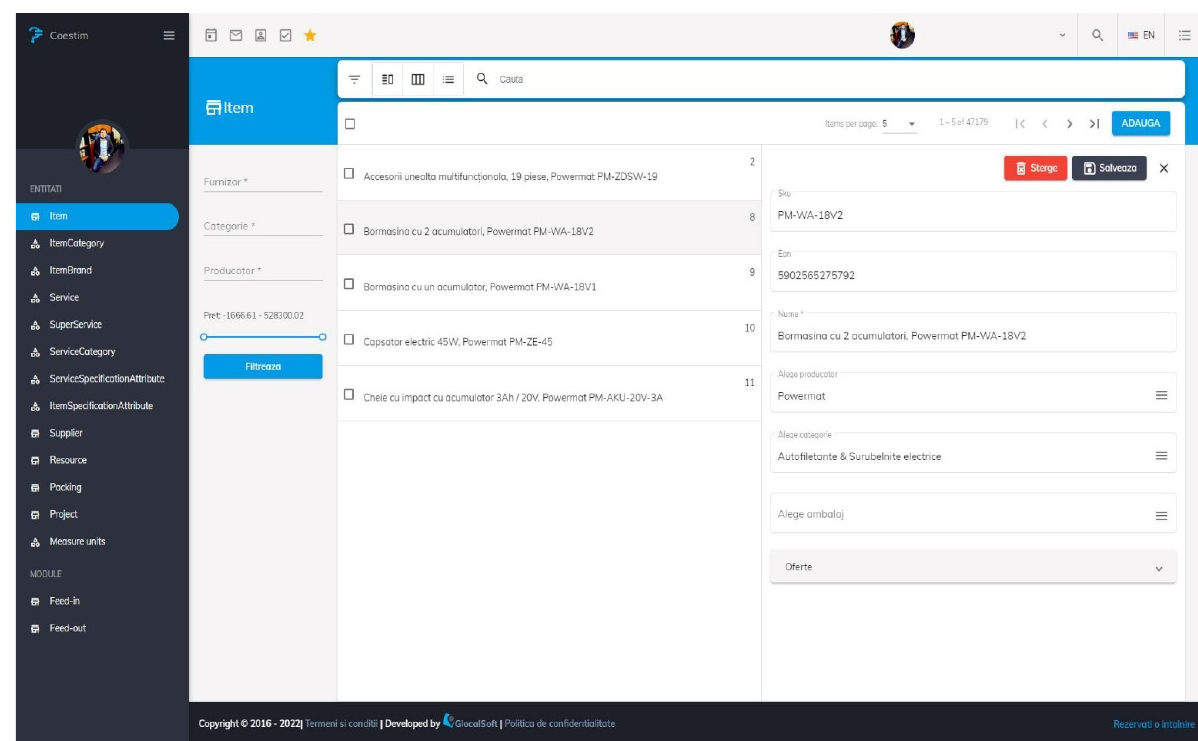
Figure 12. UI interface of the Coestim application.